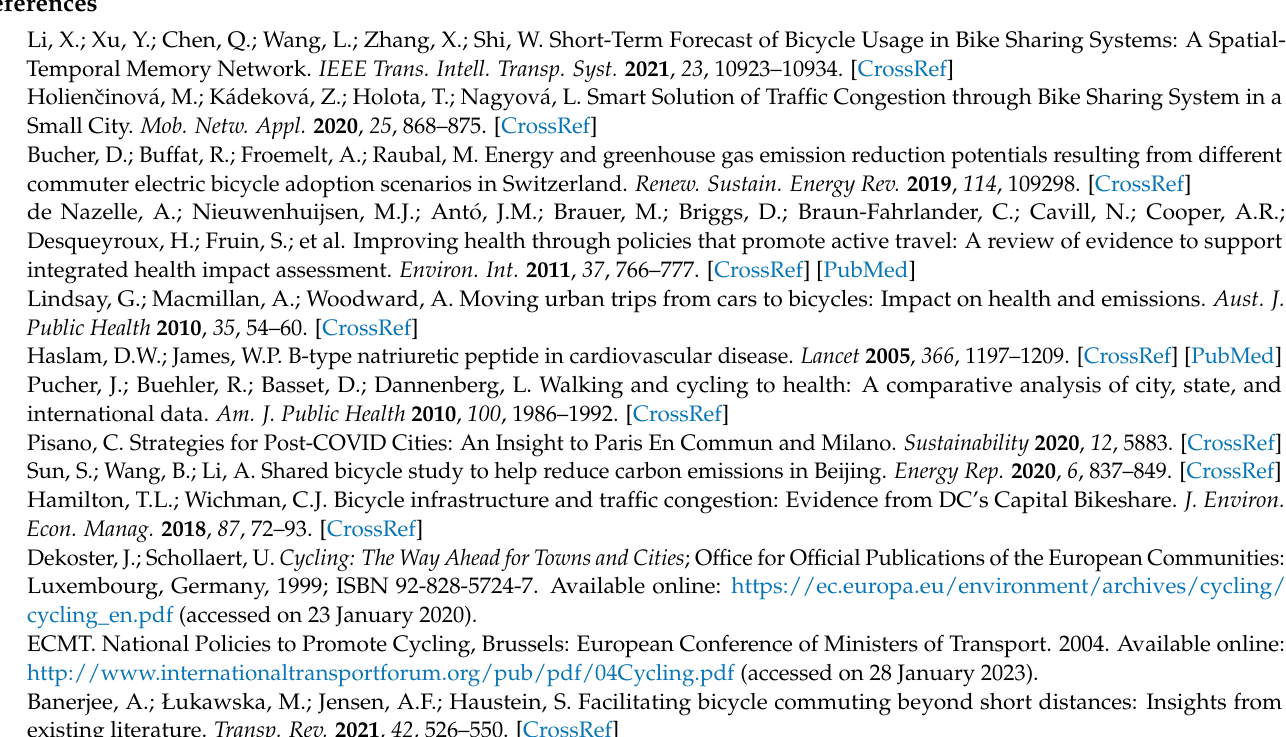
Table S1; Active modal share summarizing statistics: Table S2. Modal share and fossil energy spending to jobs only. Table S3. Modal share and fossil energy spending to jobs only. 2. Full maps for L kj = 70/20/10: (Figure S1a) Full cycling modal share to urban facilities; (Figure S1b) No cycling modal share to urban facilities; (Figure S2a) Full cycling modal share to urban facilities plus jobs; (Figure S2b) No cycling modal share to urban facilities plus jobs; (Figure S3a) Full cycling modal share to jobs; (Figure S3b) No cycling modal share to jobs; (Figure S4a) Full cycling fossil energy spending to urban facilities; (Figure S4b) No cycling fossil energy spending to urban facilities; (Figure S5a) Full cycling fossil energy spending to urban facilities plus jobs; (Figure S5b) No cycling fossil energy spending to urban facilities plus jobs; (Figure S6a) Full cycling fossil energy spending to jobs; (Figure S6b) No cycling fossil energy spending to jobs; (Figure S7a) Full cycling/no cycling modal share differential to urban facilities plus jobs; (Figure S7b) Full cycling/no cycling fossil energy spending differential to urban facilities plus